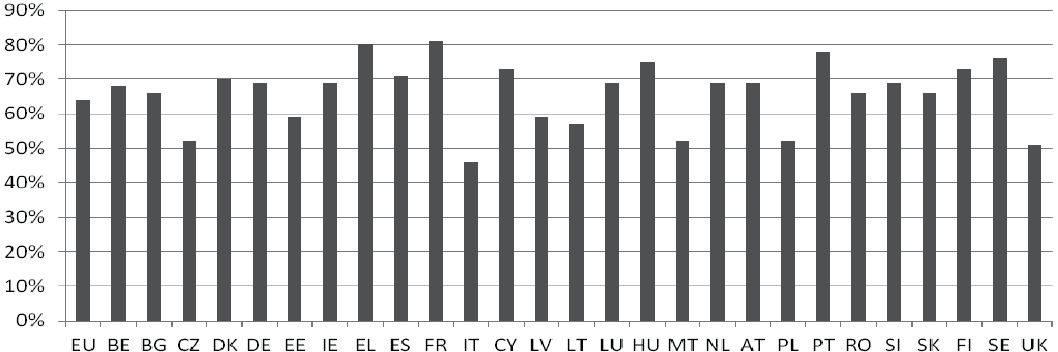
Fig. 1 The percentage of respondents who indicated “Poverty, hunger and lack of drinking water” as an answer to the question: “Which of the following do you consider to be a single most serious problem facing the world as a whole?”. Based on: Eurobarometer 372, Climate change